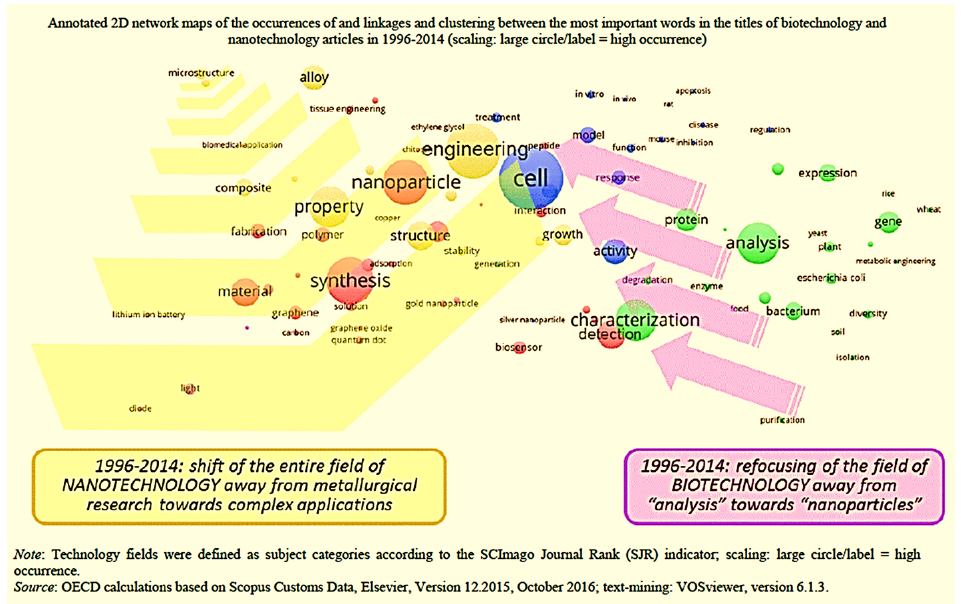
Figure 1. OCDE’s mapping on the convergence. The Figure is extracted from [14] with